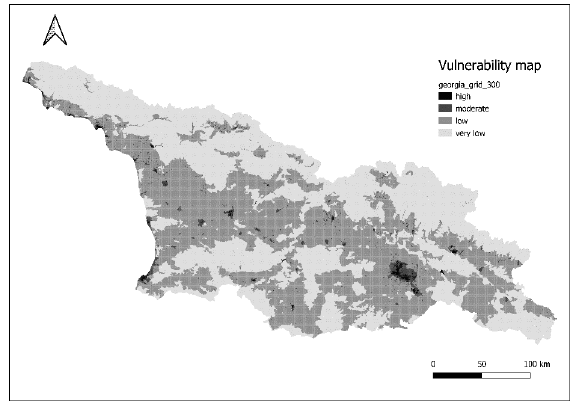
Figure 10. Vulnerability